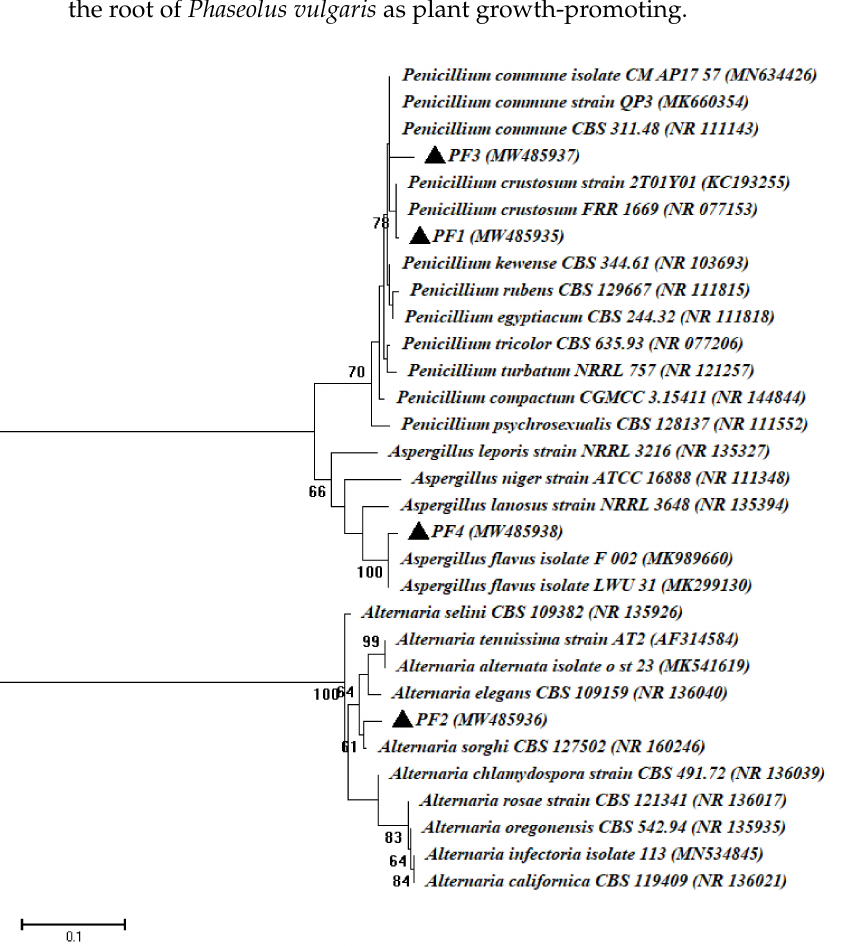
Figure 2. Phylogenetic tree of fungal strains’ ITS sequences against NCBI reference sequences (National Center for Biotechnology Information). PF1–PF4 refers to the ITS sequences of fungal isolated from common bean plants. The fungal isolates and their identities were listed in Table 1. The analysis was carried out in MEGA 6 using the neighbor- joining